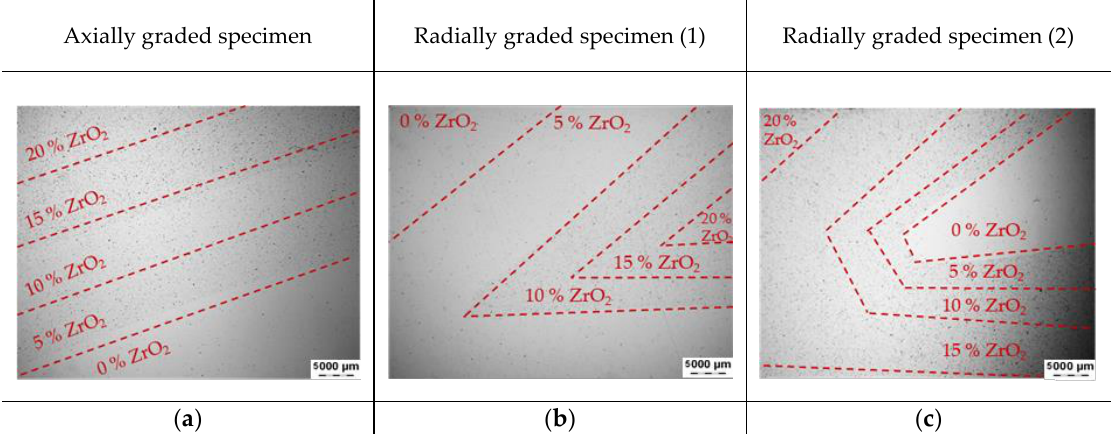
Figure 9. Specimens obtained after subjecting pre-sintered specimens to the forming process: ( a ) overview of an axially graded specimen, ( b ) overview of radially graded specimen 1, and ( c ) overview of the radially graded specimen (2).